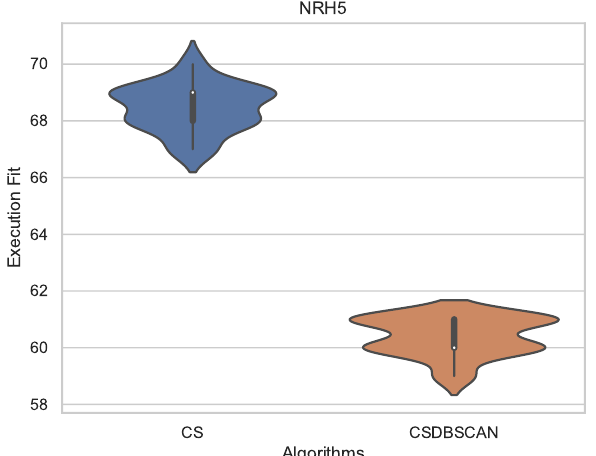
Figure 14. Instance NRH.5